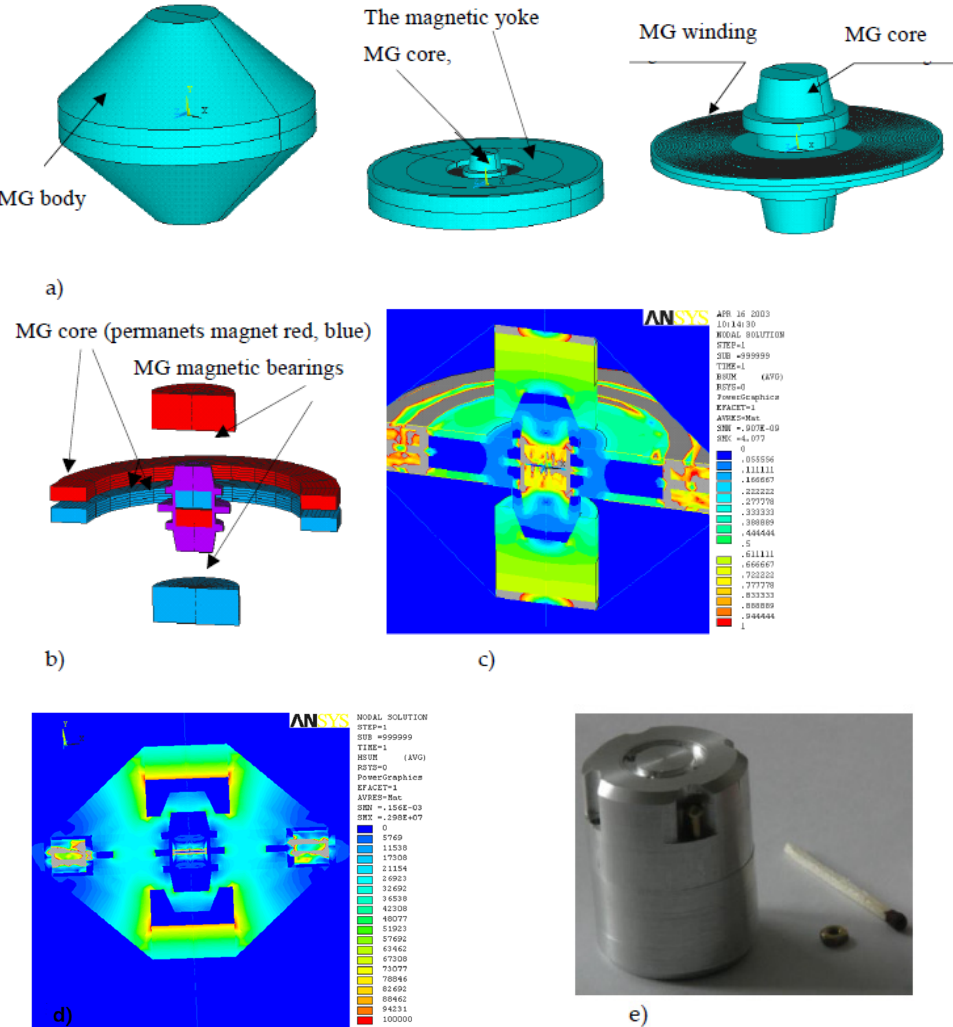
Figure 6. The 3D model, analysis of the primary version MG (magnetic bearing) and MG realization, ( a ) geometrical model components, ( b ) conception, ( c ) field distribution of magnetic flux density module B [T], ( d ) field distribution of magnetic field intensity module H [A/m], ( e ) built MG sample prepared for